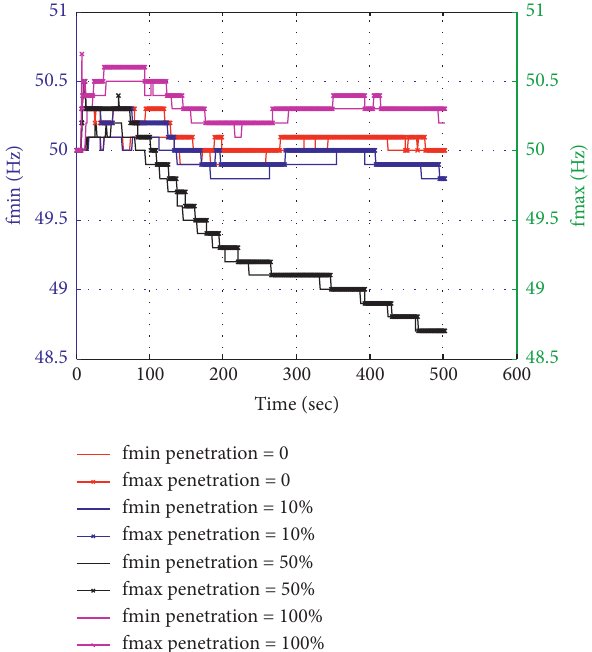
Figure 4: Minimum and maximum frequency dynamics of the system when different permeability